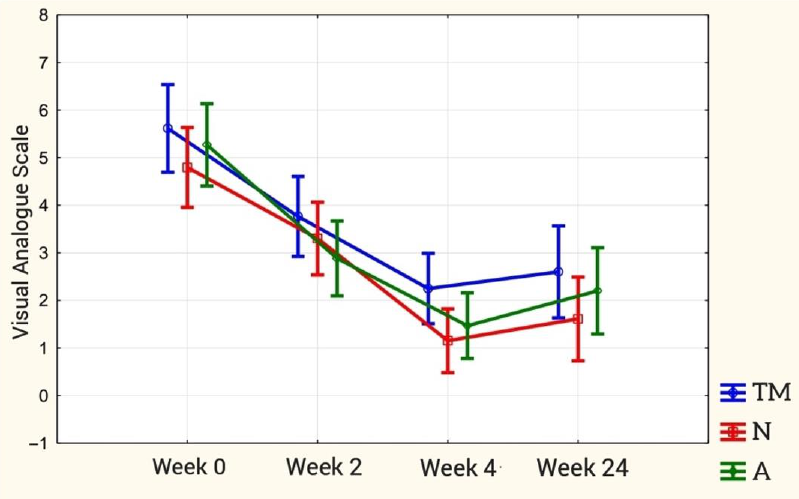
Figure 8. The course of variability of pain intensity according to the VAS scale in individual stages of therapy in relation to research